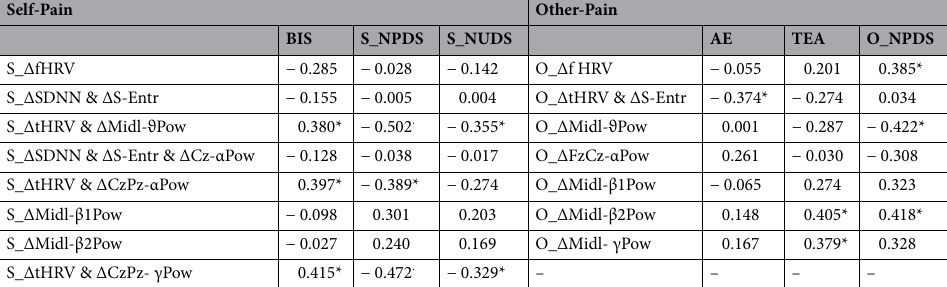
the 10th, 25th, 50th, 75th, and 90th percentile of the distribution of FFFS. Bias-corrected bootstrap confidence intervals are based on 10,000 bootstrap samples. This effect was significant and negative for FFFS scores of 17, 21, 25, and 29, corresponding to the 10th, 25th, 50th, 75th percentile. For each of these FFFS scores, the boot- strap confidence interval [BootLLCI, BootULCI] was entirely below zero ([− 0.061, − 0.010], [− 0.050, − 0.009],